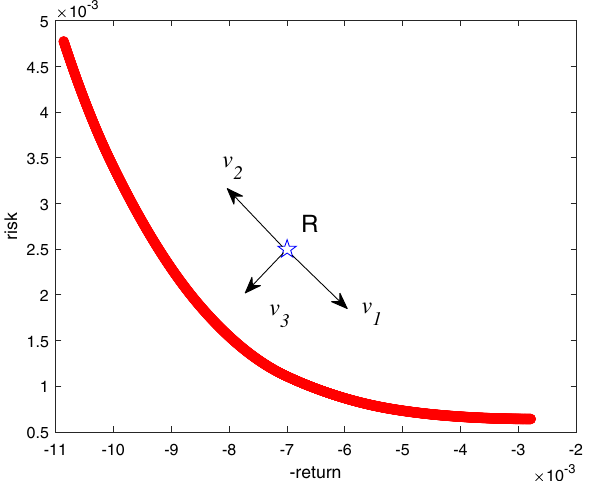
Fig. 9 Different moving directions of different occasions allocation scheme x . Besides, there exists some constraints in the application. The i -th dimensional value is bounded in [ 0 , 1 ] , and the sum of all values in a solution must be equal to 1.